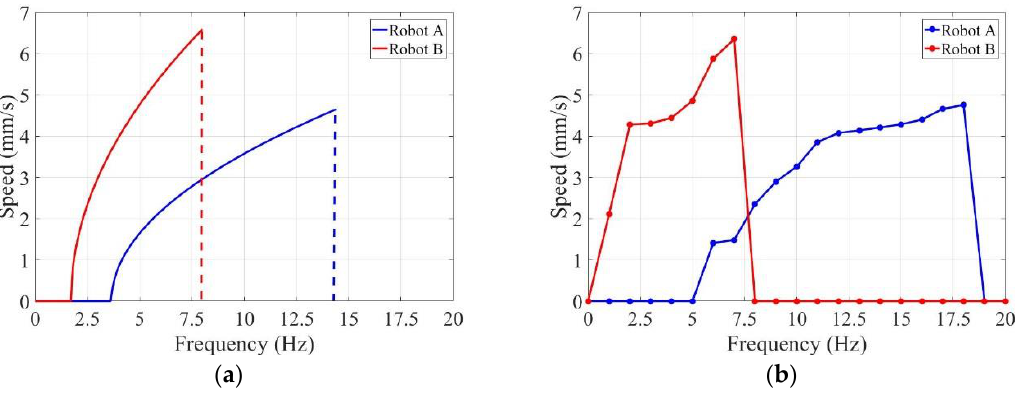
Figure 9. Relationship between axial speeds of individual capsule robots and driven frequencies of rotational electromagnetic field: ( a ) theoretical result; ( b ) experimental result.